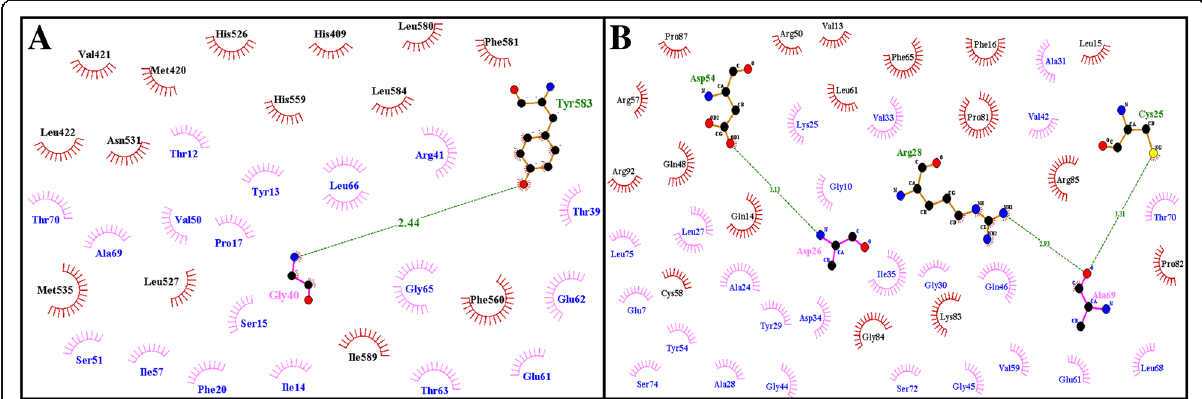
Fig. 5 2D – DimPlot representation of docking interaction. a Normal TCIRG1 with ATPV1B1. b Mutant TCIRG1 with ATPV1B1. Receptor and ligand residues involved in hydrophobic interactions are represented by brick red and pink spoke arcs ( ) respectively. Hydrogen bonding is shown by green dotted lines (